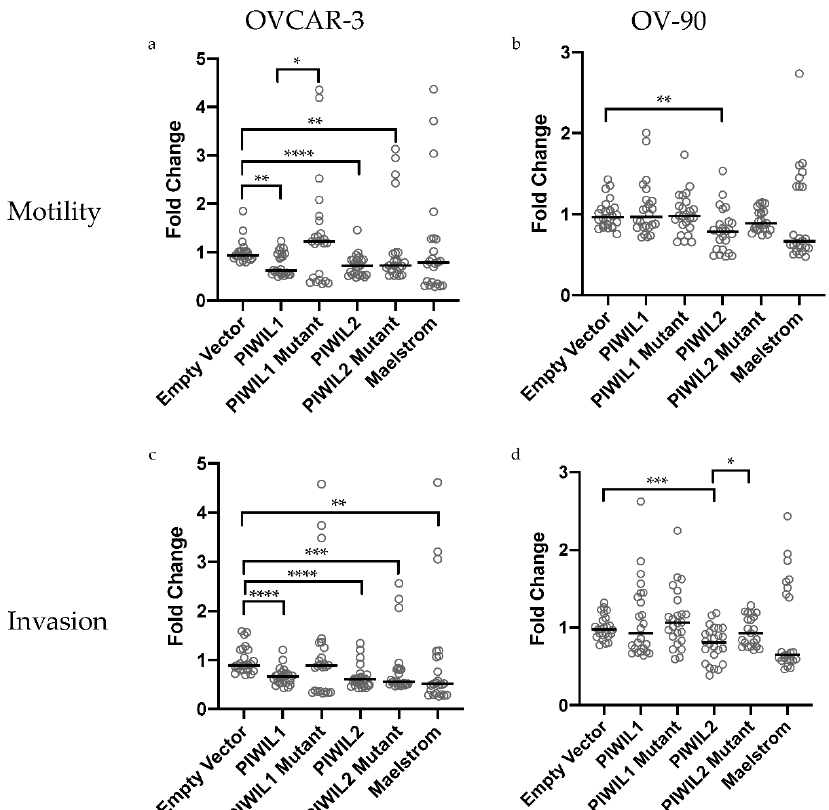
Figure 6. In vitro motility and invasion of OVCAR-3 and OV-90 cells after overexpressing piRNA pathway genes and its mutants ( n = 21–24 per cell line per transfection). ( a , b ) Motility: PIWIL1 and PL2L60 ( PIWIL2 mutant) overexpression significantly decreased OVCAR-3 motility while PIWIL2 overexpression significantly decreased motility in both OVCAR-3 and OV-90. OVCAR-3 cells overexpressing P1 ∆ 17 ( PIWIL1 mutant) had increased motility compared to empty vector and was significantly more motile than PIWIL1 overexpression. ( c , d ) Invasion: overexpression of PIWIL1 , PIWIL2 , PL2L60 and MAEL significantly decreased OVCAR-3 invasion while PIWIL2 overexpression significantly decreased OV-90 invasion. OV-90 cells overexpressing PL2L60 had significantly increased invasion compared to PIWIL2 overexpression. All fold changes were calculated relative to empty vector. Three biological replicates were carried out per cell line per transfection group. Bar represents median values plotted for all the datasets. Statistical tests Mann − Whitney U (non-normal distribution) or unpaired t -test (normal distribution) were used accordingly. * p < 0.05; ** p < 0.005; *** p < 0.0005; **** p < 0.0001.